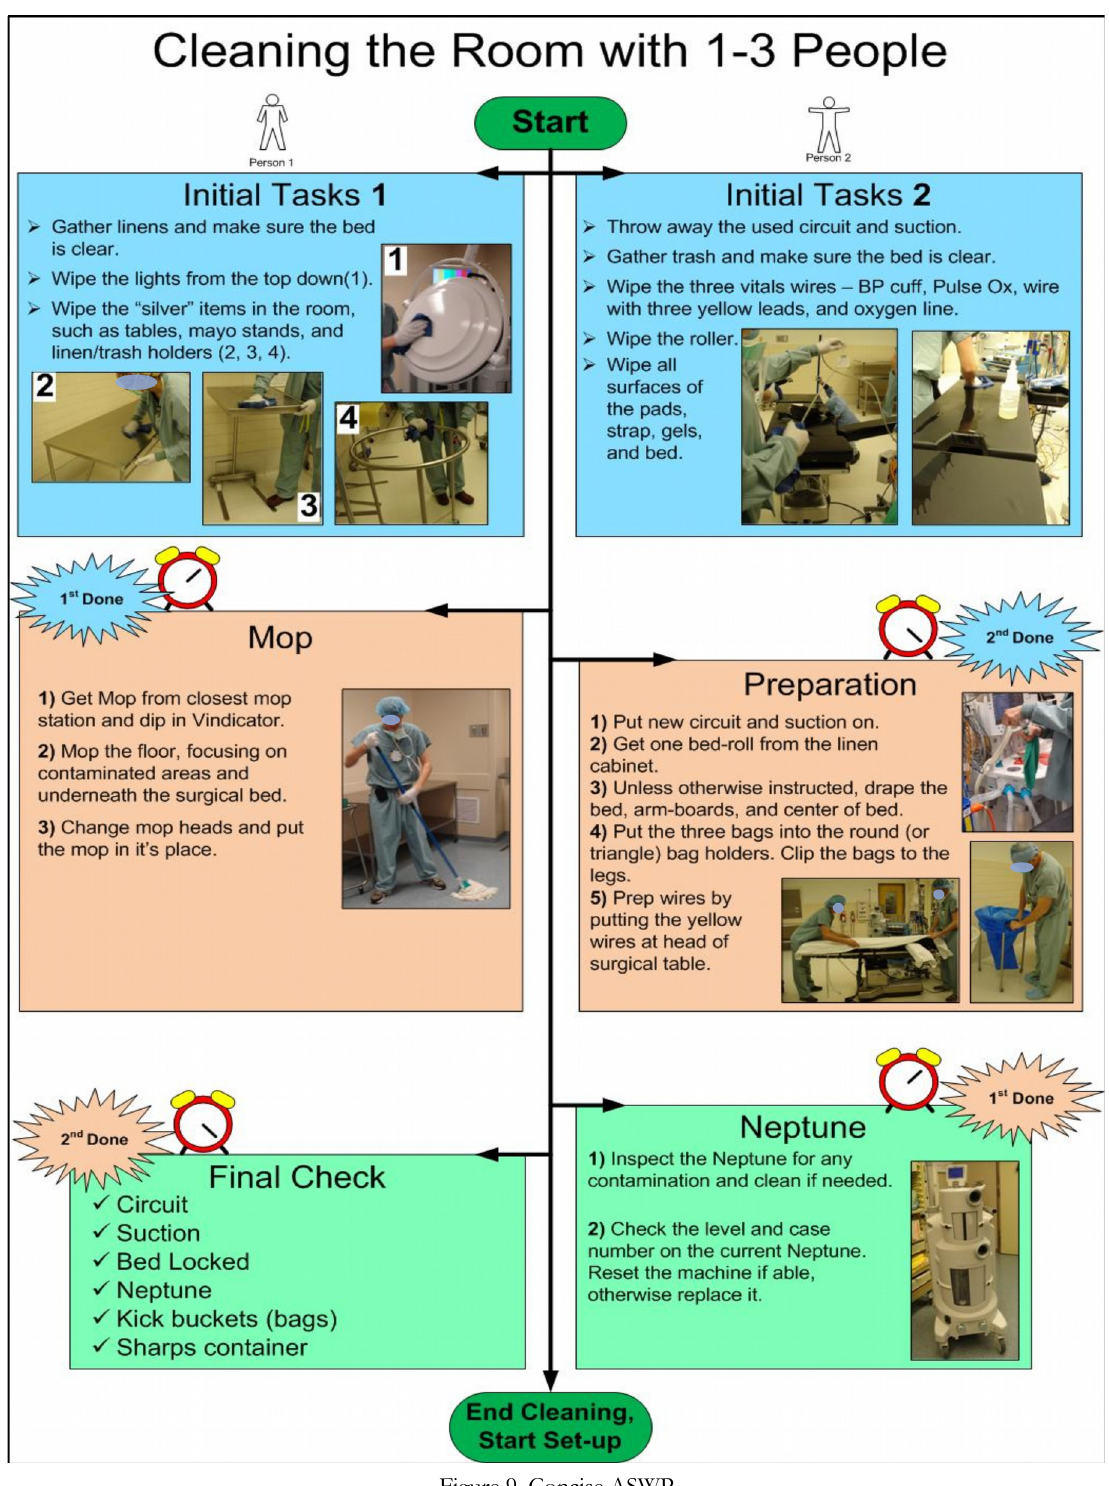
Figure 9. Concise